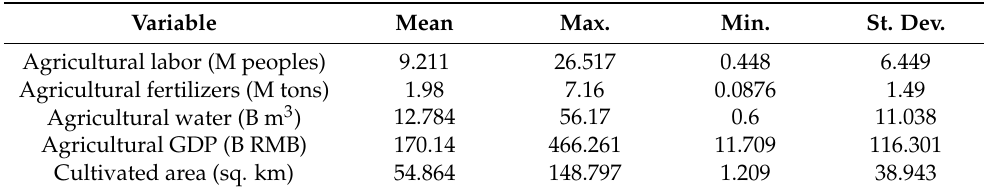
Table 3. Input and output statistics: 2012 to 2016. Variable